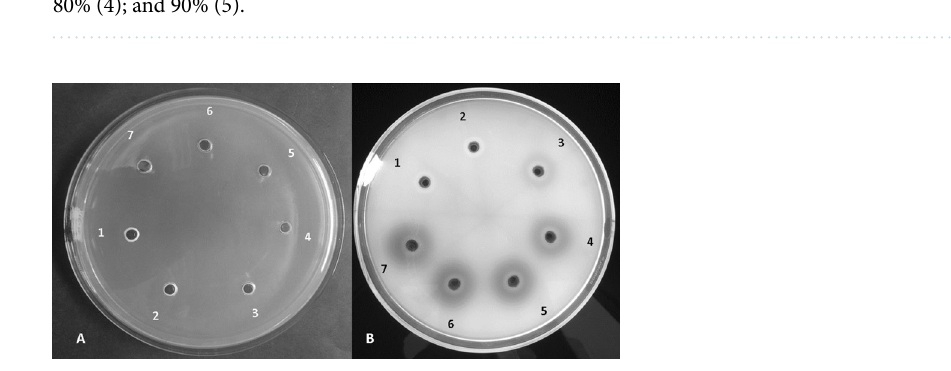
Figure 4. Representative images of laminarinase plate assay for Short Time Incubation (STI) samples (30%- 90% AS treatment). ( A ) Laminarinase plate under visible white light. 30% (1); 40% (2); 50% (3); 60% (4); 70% (5); 80% (6) and 90% (7). ( B ) Laminarinase plate under UV light (365 nm). 30% (1); 40% (2); 50% (3); 60% (4); 70% (5); 80% (6) and 90%